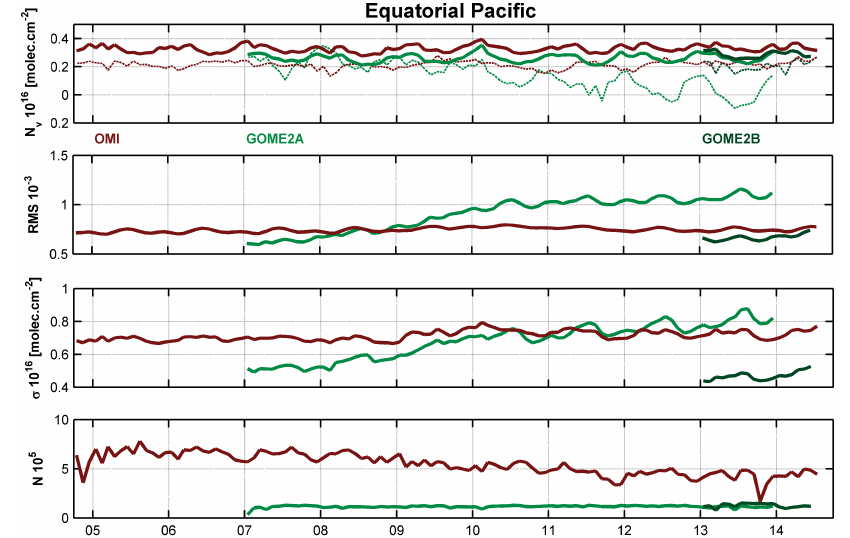
Figure 7. Time series of H 2 CO retrieval statistics for OMI and GOME-2 on METOP-A and MetOp-B in the remote equatorial Pacific region ([ − 15, 15] ◦ lat., [180, 240] ◦ long.). The first panel presents the H 2 CO vertical columns, before and after background correction (dotted and plain lines). The second, third and fourth panels present respectively the fit residuals, the column standard deviation and the number of valid observations. See text for details on the DOAS retrieval